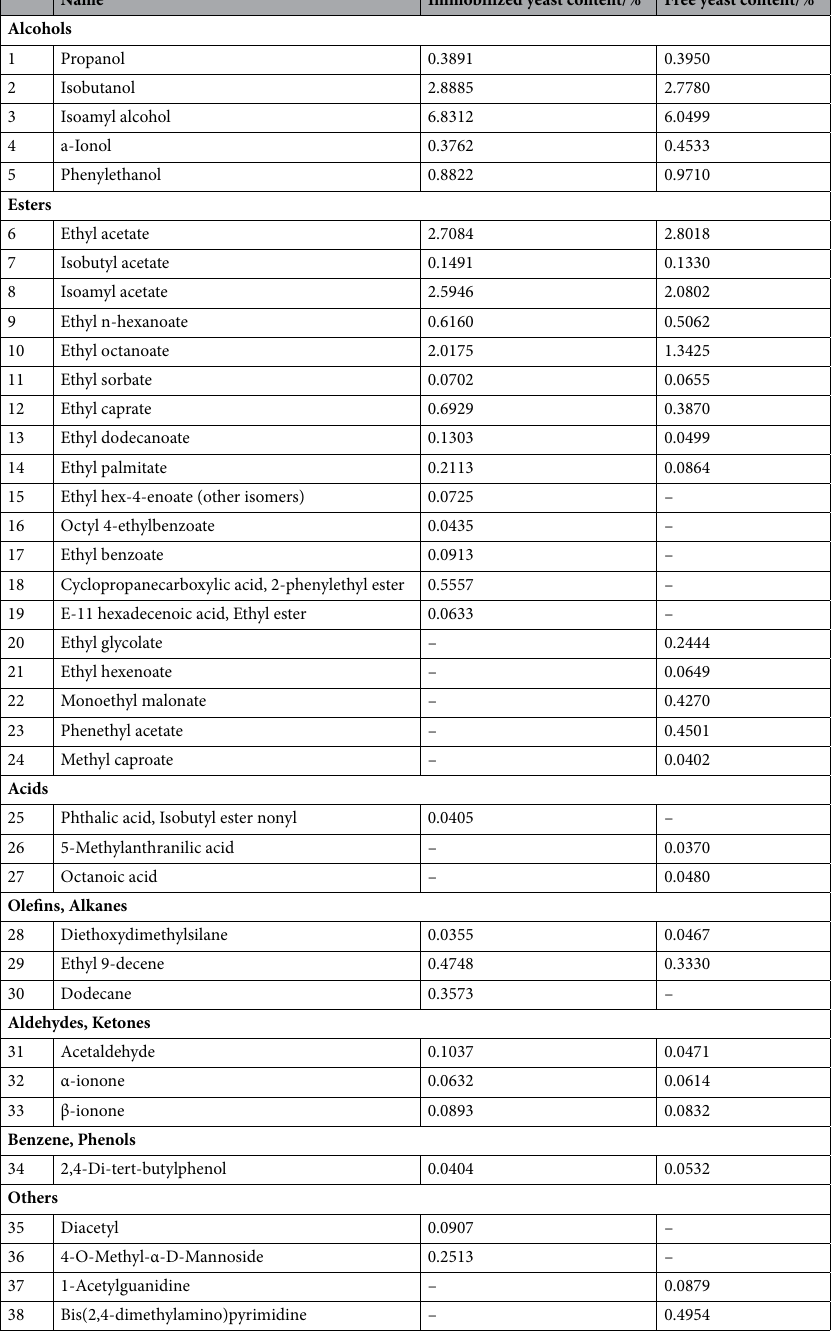
Table 8. Main aroma components of red raspberry wine fermented with Immobilized yeast or free